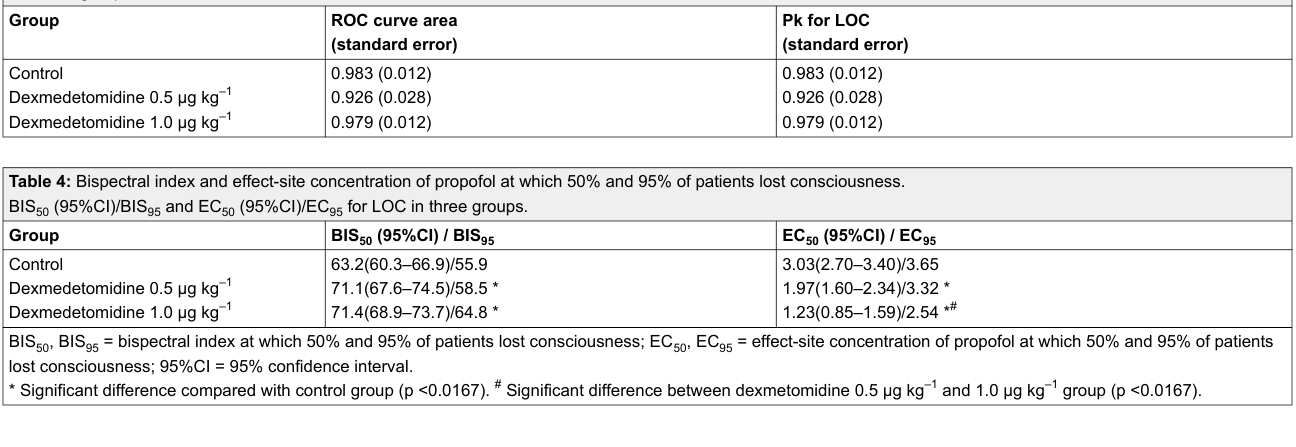
Pk for LOC (standard error)